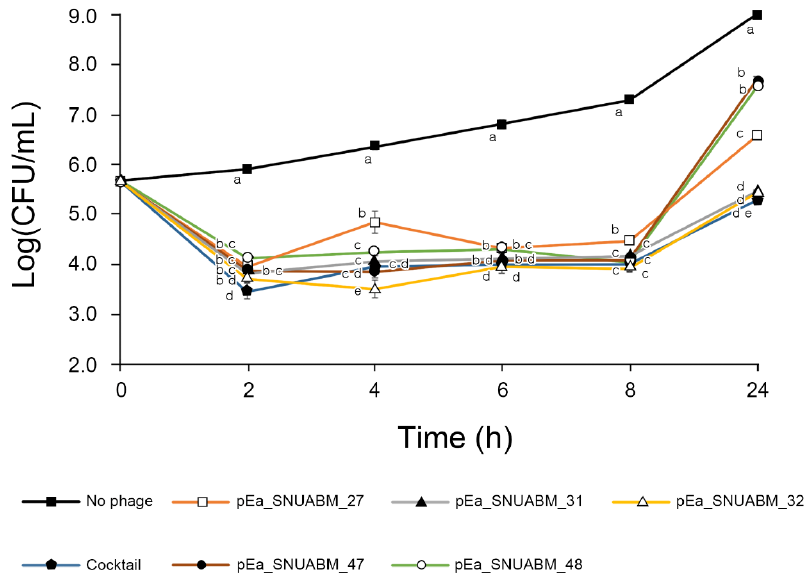
Figure 2. In vitro bactericidal effect of Erwinia phages ϕ 27, ϕ 31, ϕ 32, ϕ 47, ϕ 48, and their cocktail. The viable bacterial cells were counted over 24 h. The E. amylovora strain TS3128, a reference strain for research in Korea, was used. The bars of each point indicate the standard deviation. Statistical significance was calculated using the one-way analysis of variance test with Tukey post-hoc, and the significance threshold was set at p < 0.05. Means at the same sampling time point with different letters (a–e) are significantly different.